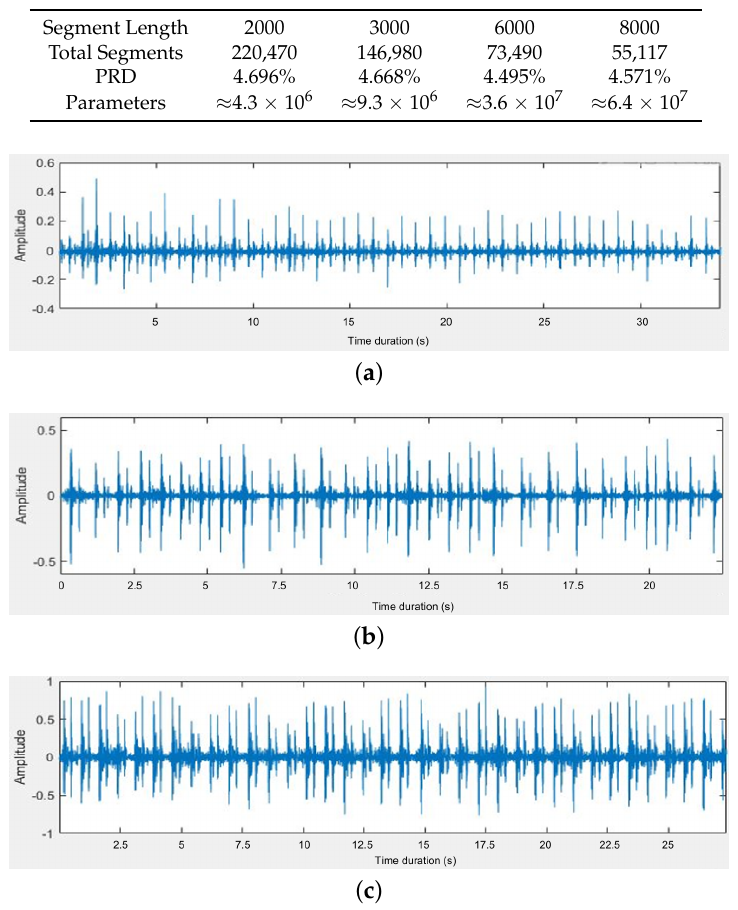
Figure 2. Three collected trace files of heart sound in the Dalian University of Technology heart sounds